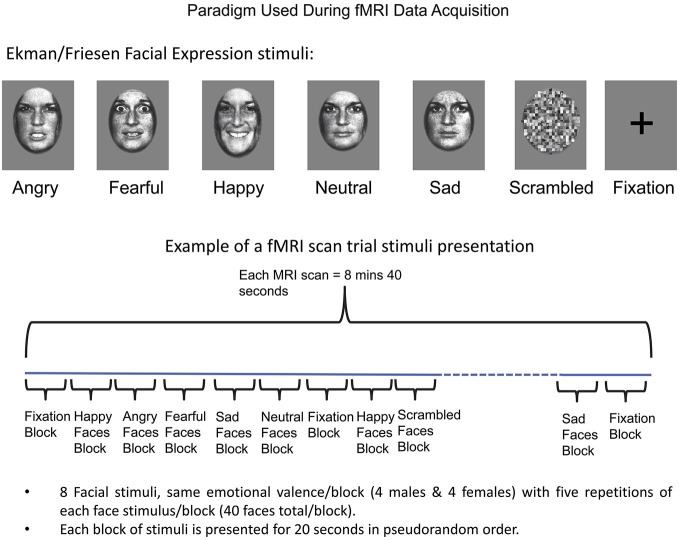
Schema for Experimental Paradigm Used with fMRI. At top, the categories of facial expressions used are shown along with baselines (scrambled faces and fixation). A schema of how these stimuli were presented as blocks is shown at bottom, along with details relating to number of stimuli used per block. See Methods Section for further detail.